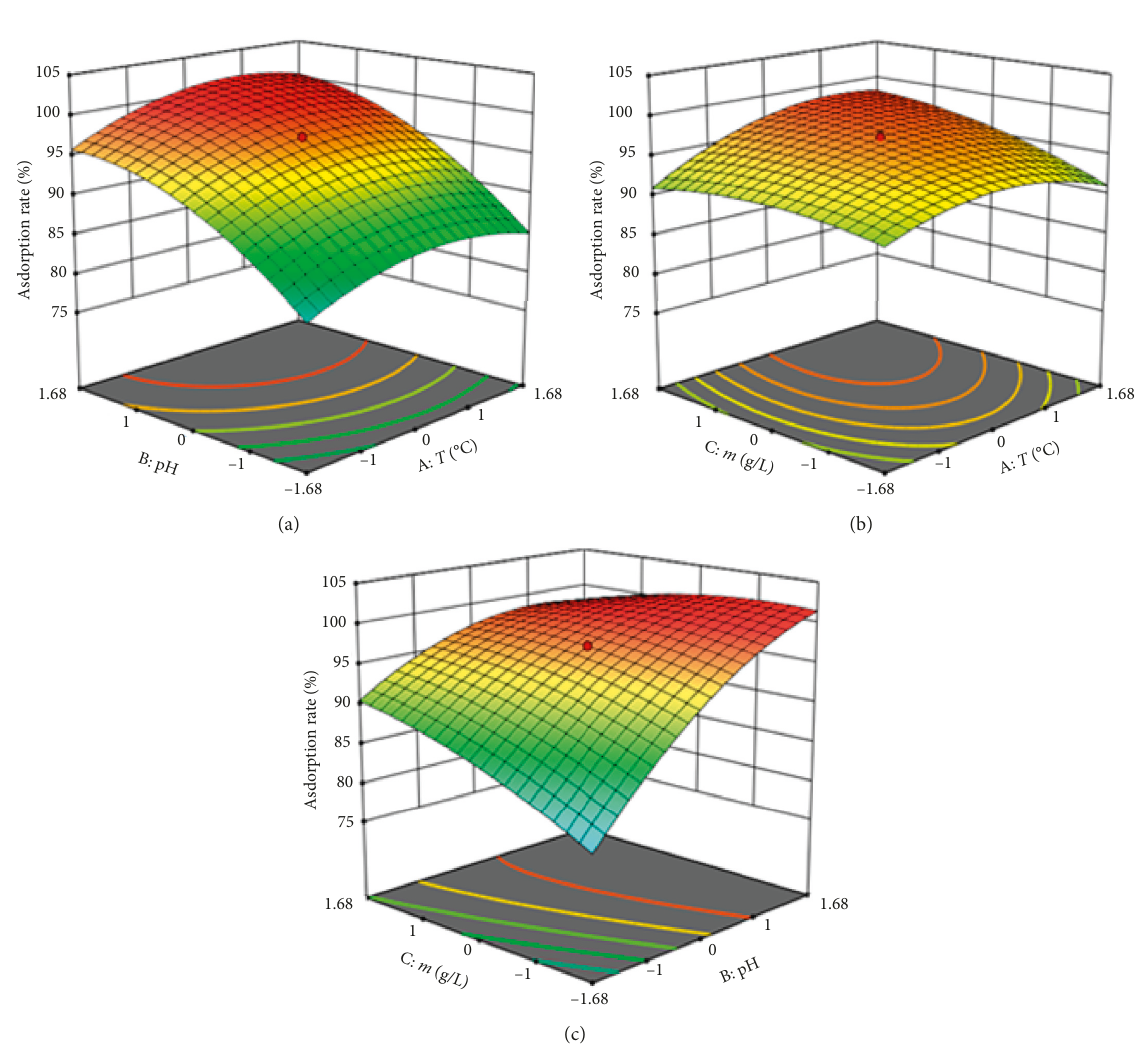
Figure 10: Response surfaces showing adsorption efficiency as function of (a) temperature and pH, (b) temperature and adsorbent dose, and (c) pH and adsorbent